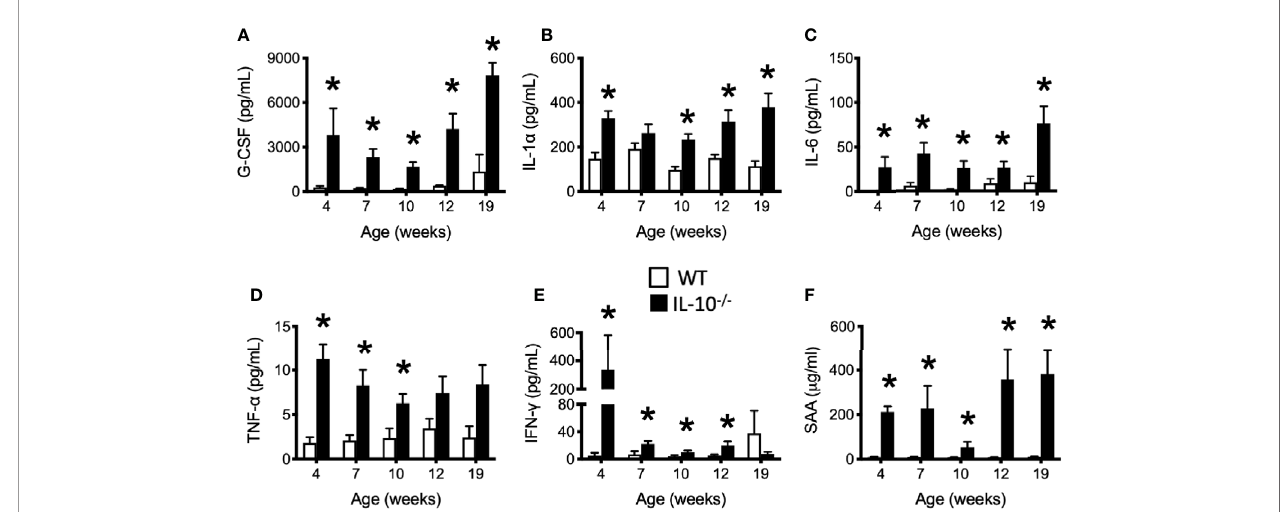
FIGURE 6 | Levels of serum cytokines and chemokines that were persistently elevated in the serum of IL-10 -/- mice. Immune factors assayed in serum samples collected between 4 and 19 weeks of age include: (A) G-CSF; (B) IL-1 a ; (C) IL-6; (D) TNF- a (E) IFN- g ; and (F) serum amyloid A (SAA). Serum samples were collected from the IL-10 -/- mice (black bars) and WT mice (white bars). Data are presented as mean ± SEM. * = p ≤ 0.05 comparing WT and IL-10 -/- for each individual time point. The number of mice used for each strain at each time point varied as follows: at 4 weeks of age, n = 5; at 7 weeks of age, n = 10; at 10 weeks of age, n = 9; at 12 weeks of age, n = 13; at 19 weeks of age, n = 5.